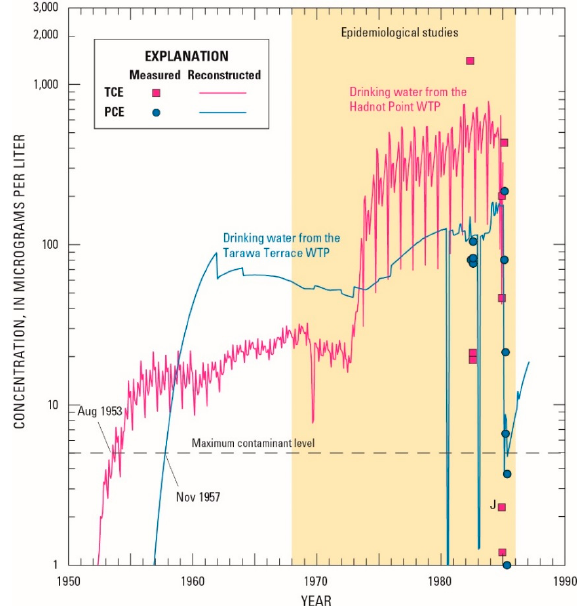
Figure 6. Reconstructed (simulated) drinking-water and measured concentrations of tetrachloroethylene (PCE) and trichloroethylene (TCE) at the Tarawa Terrace and Hadnot Point water treatment plants, U.S. Marine Corps Base Camp Lejeune, North Carolina (from